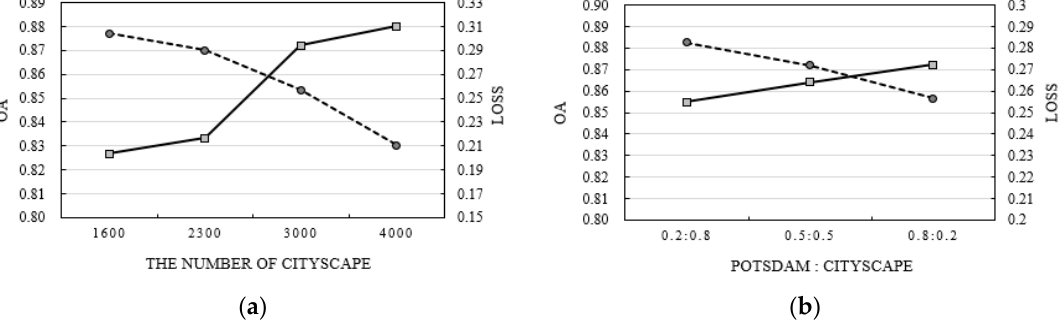
Figure 8. OA and loss of the test set when ( a ) the number of Cityscape datasets was varied and when ( b ) the weight values of the Potsdam and Cityscape were changed